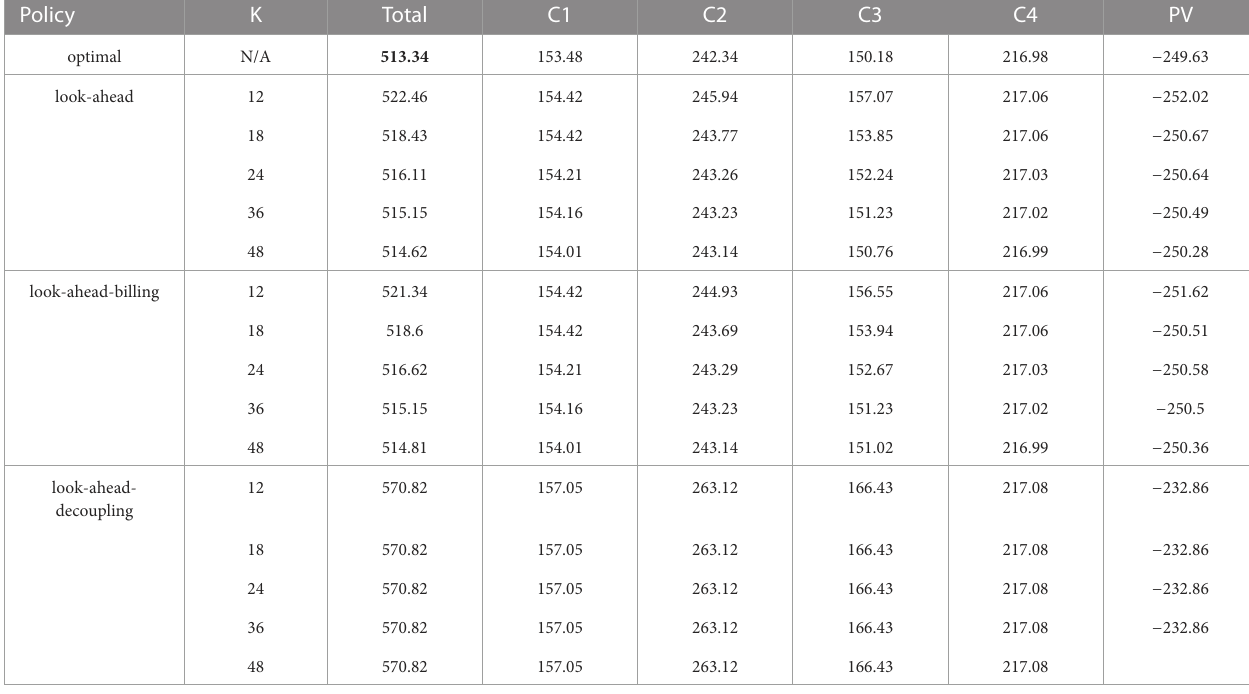
TABLE6 Size(financial)oftheoverallelectricitybillandthoseforeachindividualmemberbytestingthethreepolicieswithseveralpolicyhorizonsforCaseII, comparedwiththe optimal policy(equivalenttothelook-aheadpolicywith K = T = 720 ).Sincethesizeoftheelectricitybillofthemember6is0regardlessofthe testedpolicy,thecorrespondingcolumnisnotreported.